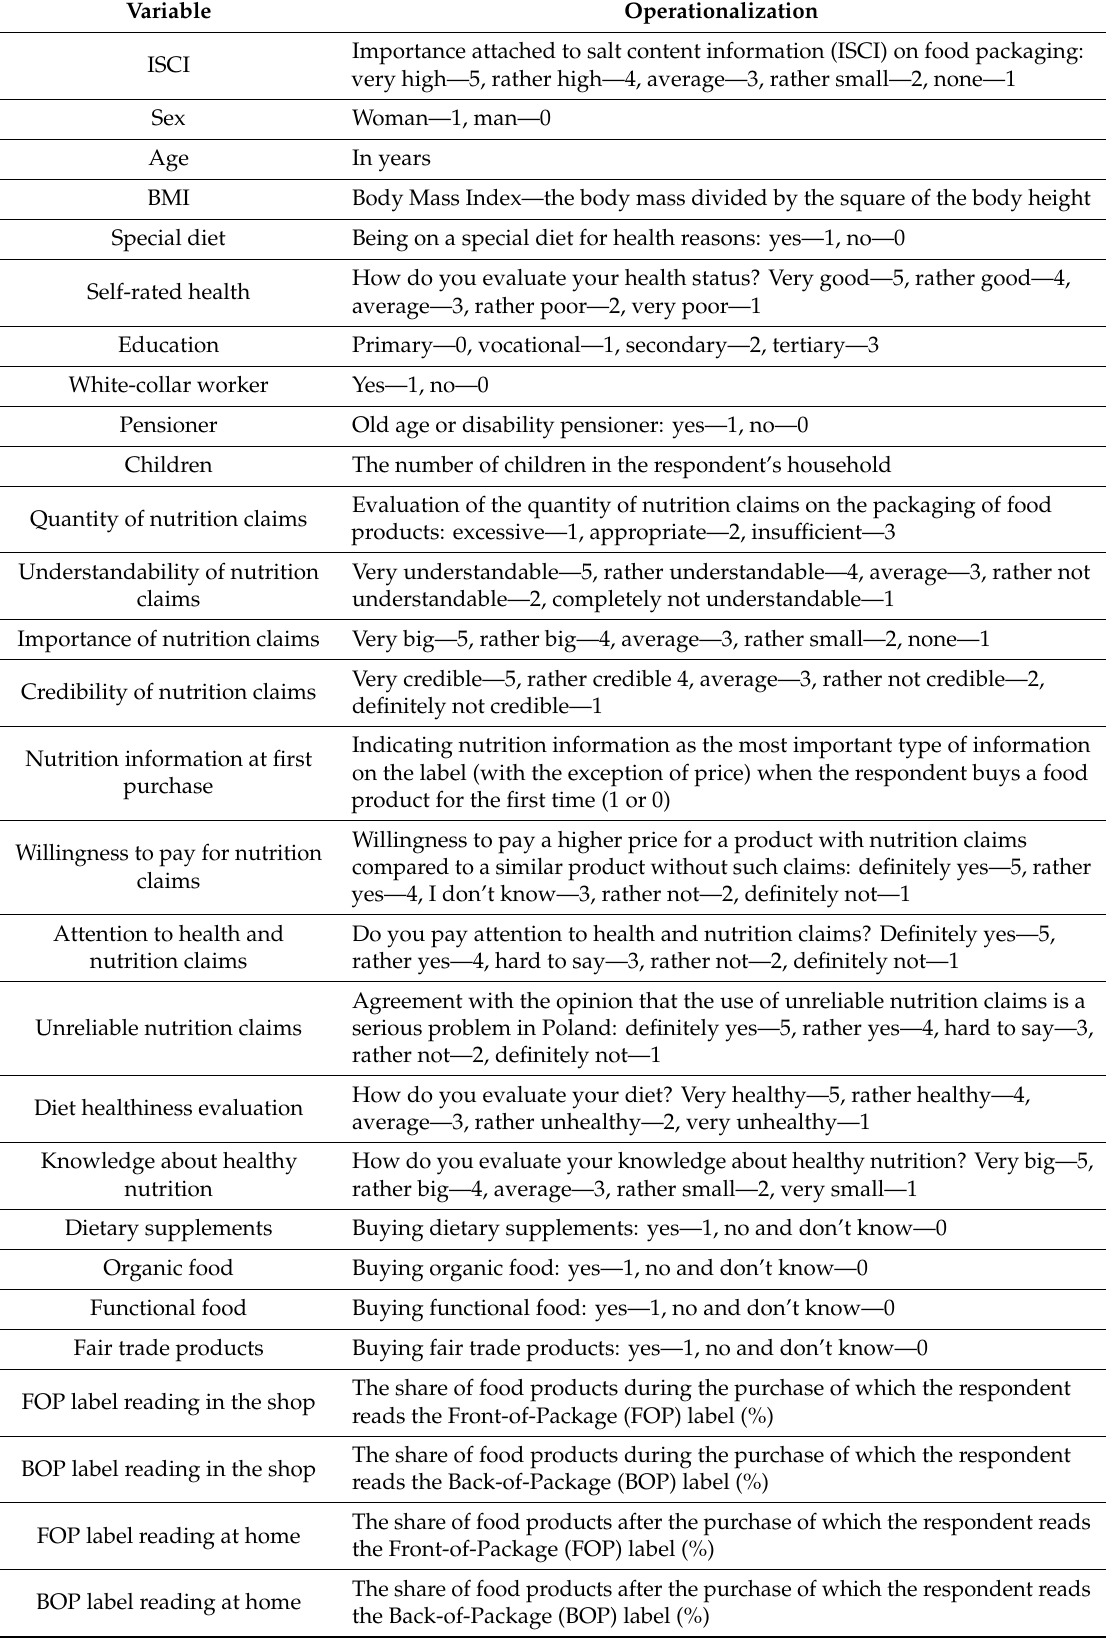
Table 1. Operationalization of variables included in the regression models. Variable